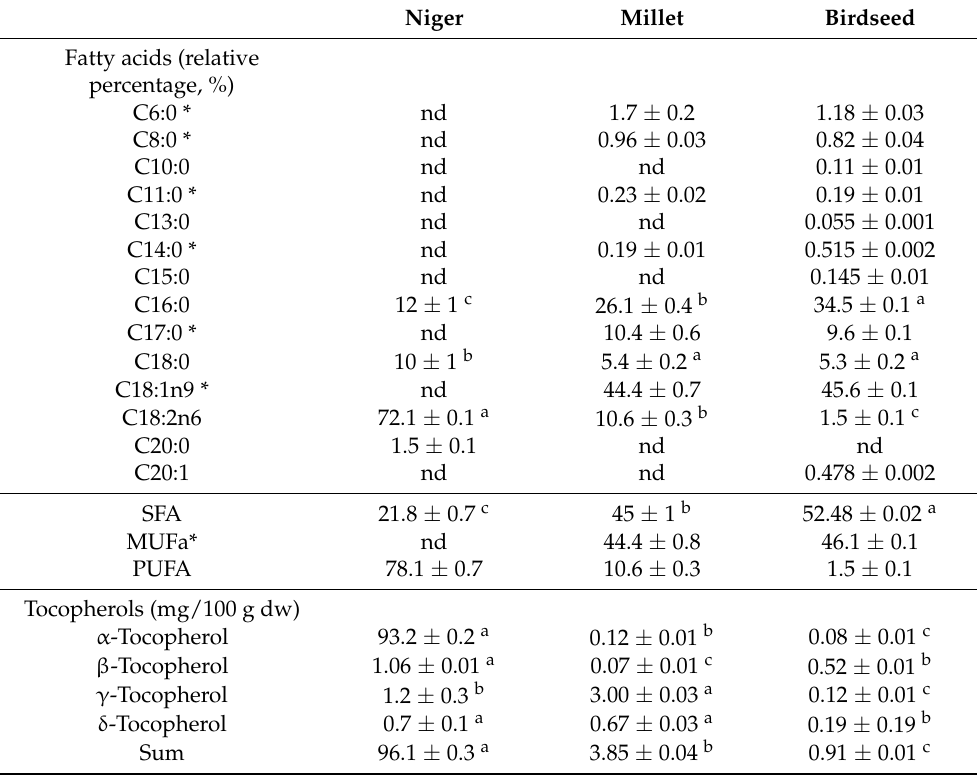
Table 4. Fatty acid and tocopherol compositions of niger, millet and birdseed (mean ± SD). Niger Millet Birdseed Fatty acids (relative percentage, %) C6:0 *